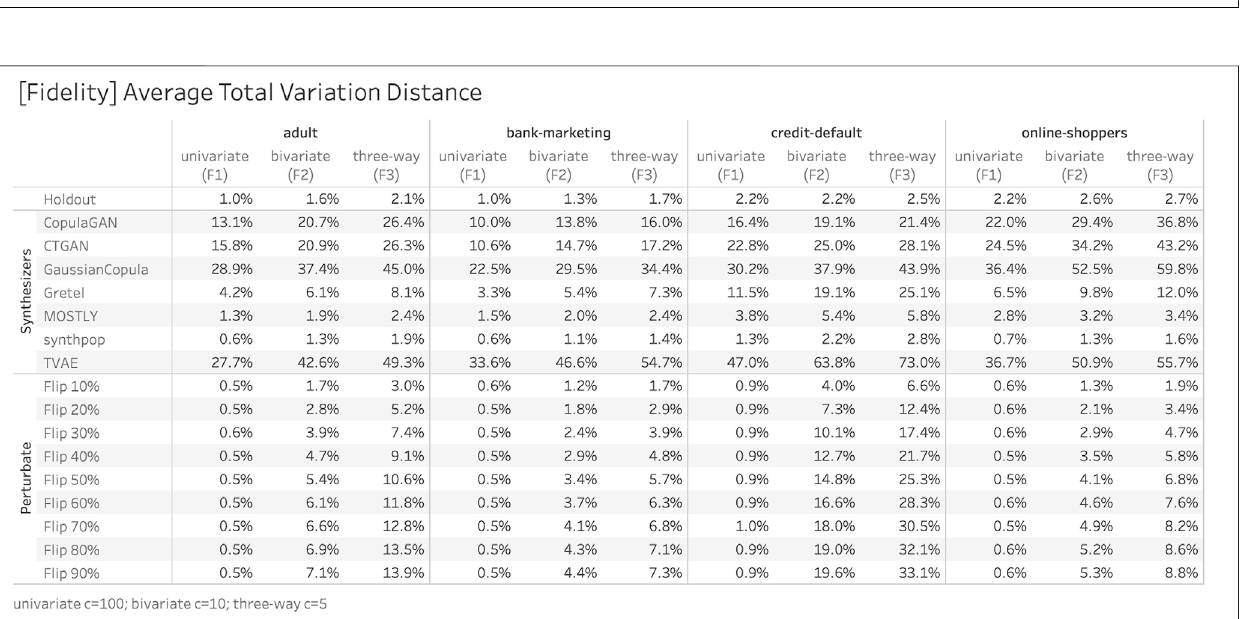
FIGURE 8 | Selected three-way marginal distribution for dataset “ adult ” across synthesized data and across perturbated data. Their total variation distance (TVD) with respect to the training set, displayed as percentages in brackets, contribute to the respective F 3 fi delity measure indicated as percentages in brackets.